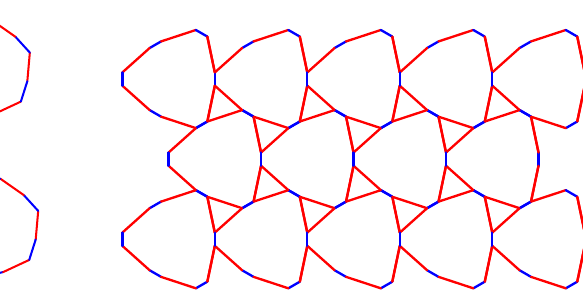
Fig. 37: Angles of both 12 -gons are alternating (D).